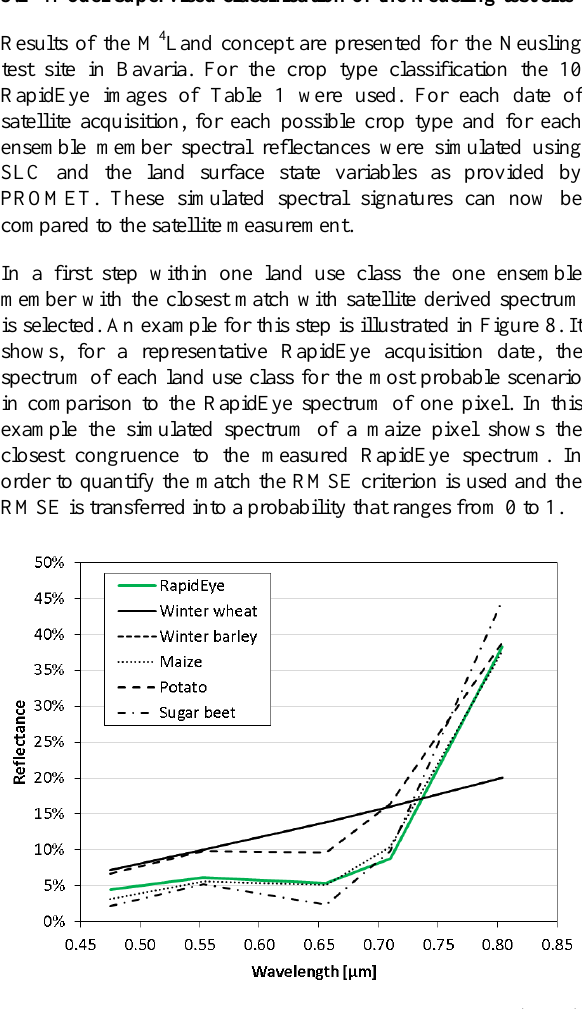
Figure 8. Comparison of a RapidEye observed spectrum (green) of one pixel on 21 th of August 2010 with modelled spectra (black) for different land cover